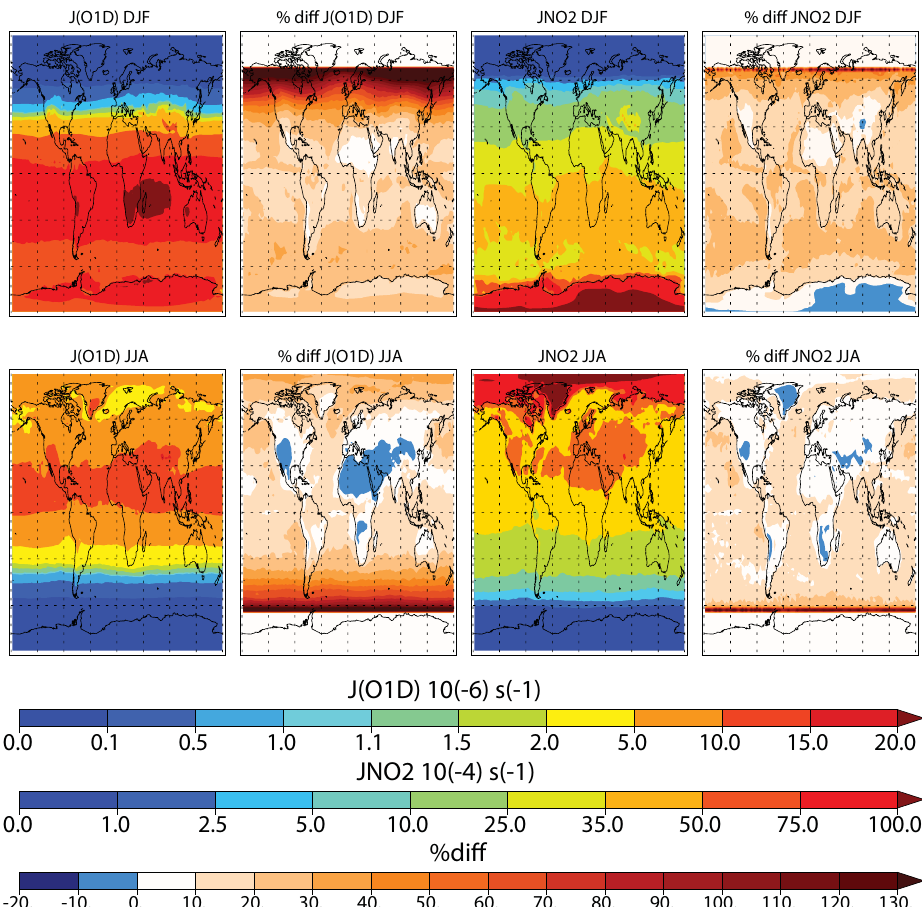
Fig. 2. The same as Fig. 1 but for the seasonal surface means for J